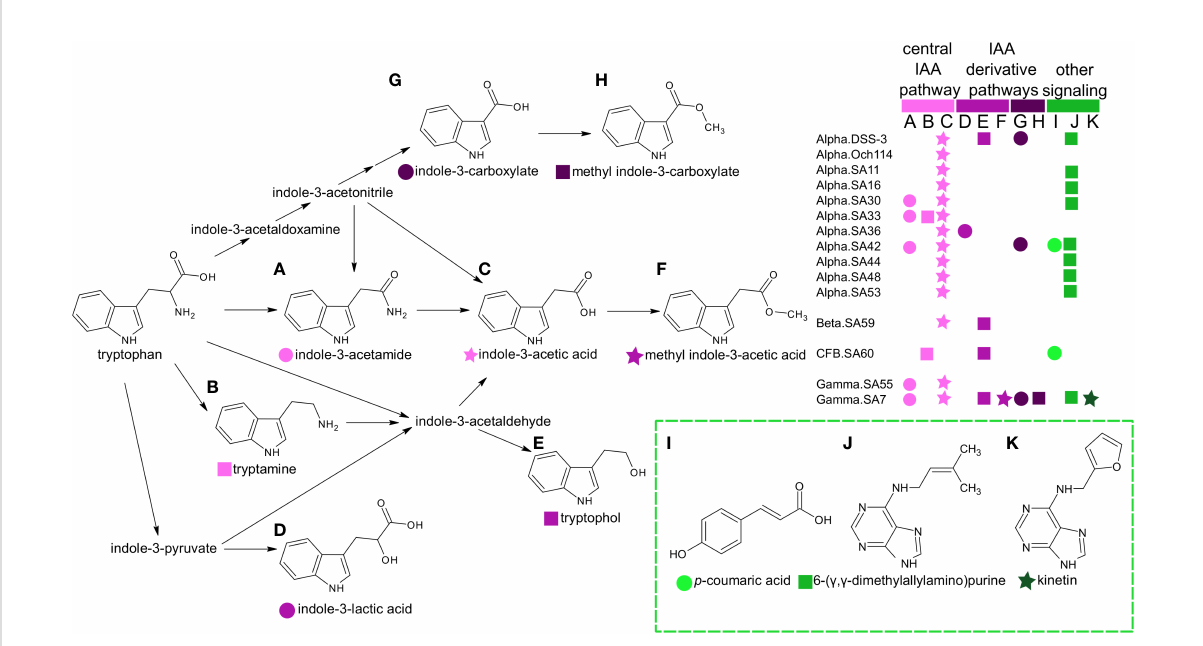
FIGURE 4 Distribution of phytohormones, cytokinins, and other potential signaling molecules in marine heterotrophic bacteria. Metabolites labeled A – H have shaded pink symbols based on whether they belong in the central pathways from tryptophan to IAA (light pink) or represent indole derivatives indole-3-lactic acid, tryptophol, methyl-indole-3-acetic acid (medium pink) or carboxylated forms (dark pink). These indole pathways have been previously described in bacteria and plants (Böttcher et al., 2014; Duca and Glick, 2020). Additional cytokinins and signaling molecules (labeled I – K ) are colored green. The legend indicates the distribution of metabolites among the heterotrophic bacterial taxa used in this study. Bacteria are labeled according to taxonomic group and strain ( “ group.strain ” as in Table 1). Group abbreviations are the following: Alpha, alphaproteobacteria; Gamma, gamaproteobacteria; Beta, =betaproteobacteria; CFB,